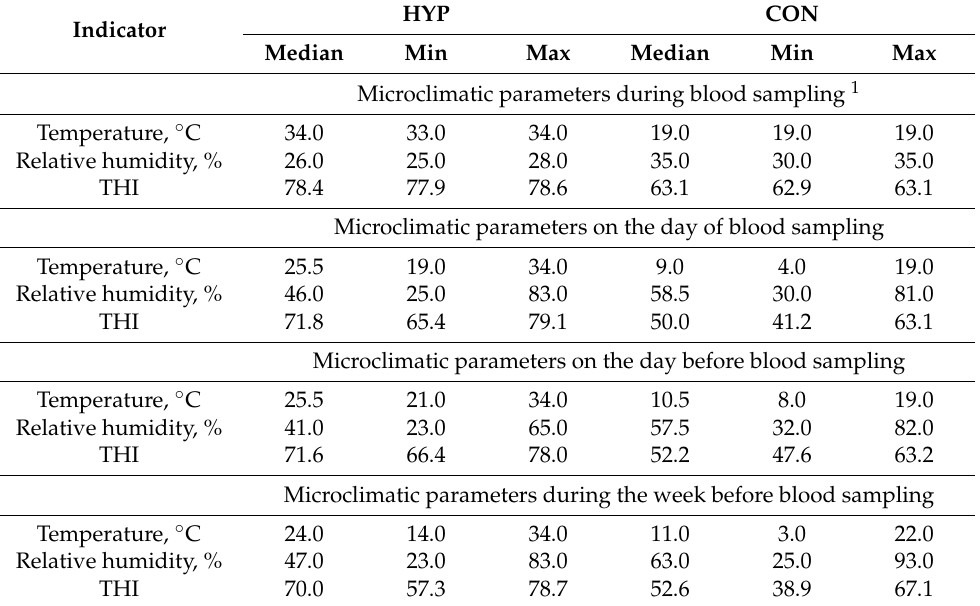
Table 1. Climate conditions in the barn under conditions of hyperthermia (HYP) and during the control period (CON), THI, temperature-humidity